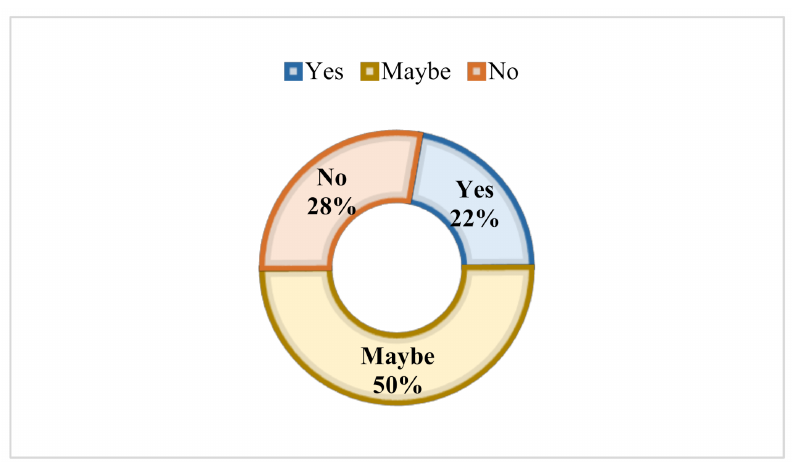
Figure 6. Non-users’ percentage of willingness to use reclaimed water to irrigate their